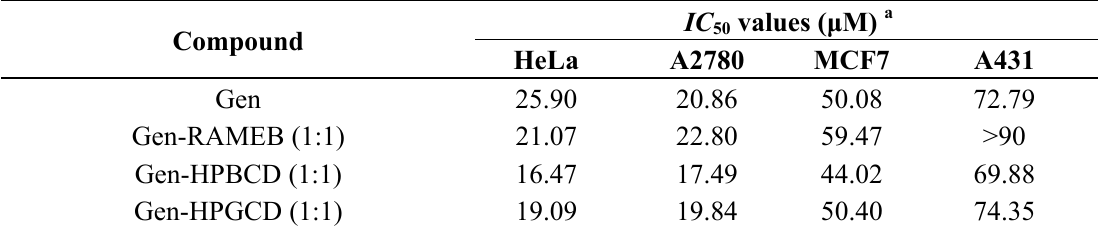
Table 3. Calculated antiproliferative IC four different human cancer cell